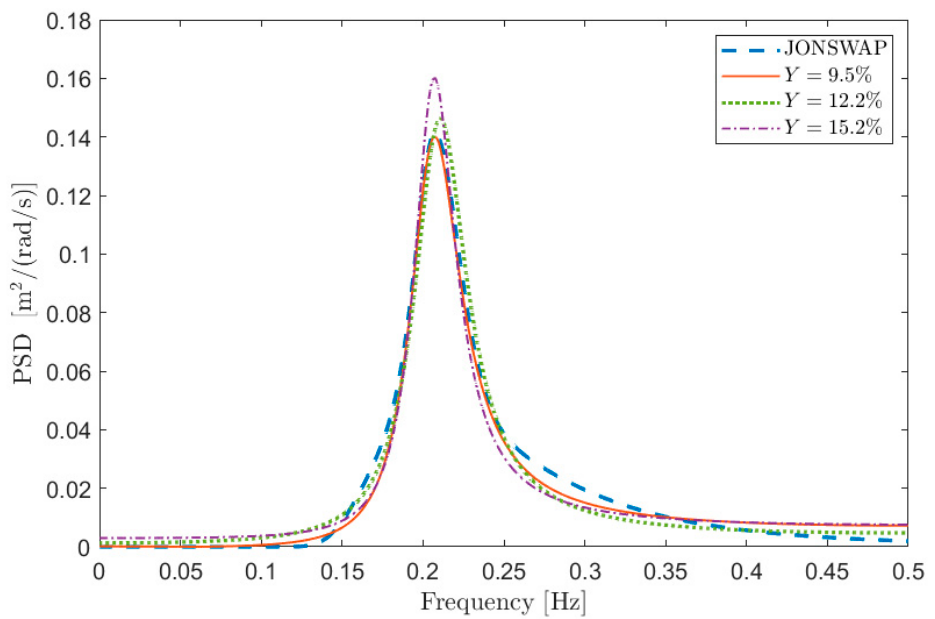
Figure 12. Reconstructed PSD and the corresponding PSD generated with the procedure given in Section 5 (sea state 2 in Table 1) for different 𝑌 values.